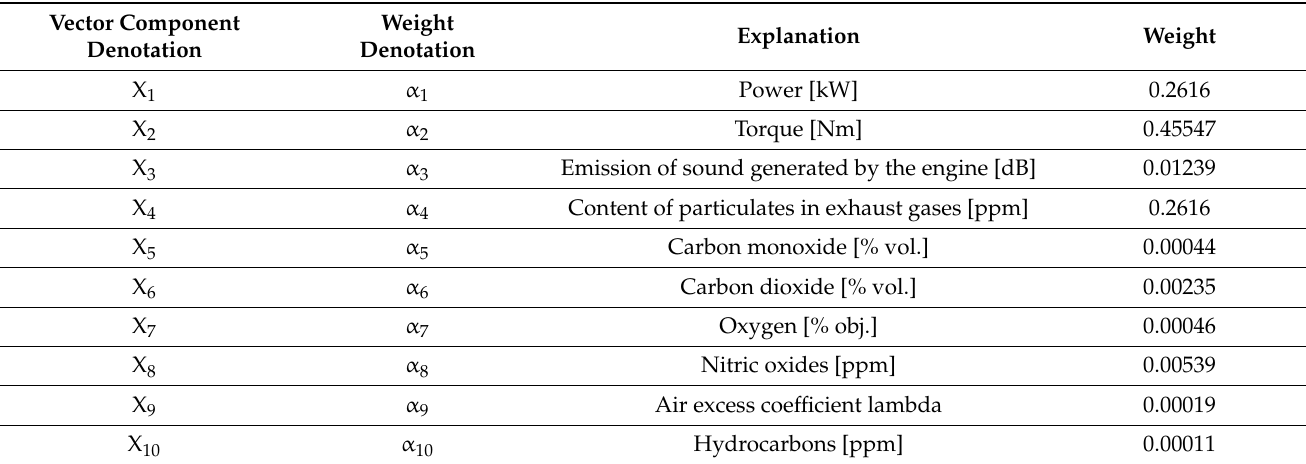
Table 5. Values of weights for particular parameters